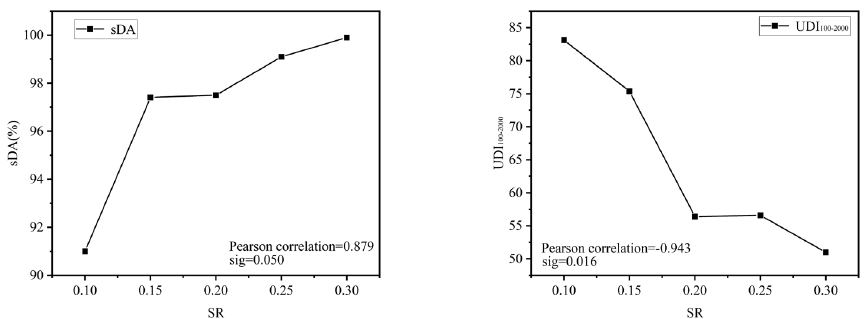
Figure 13. Analysis of skylight ratio simulation results.